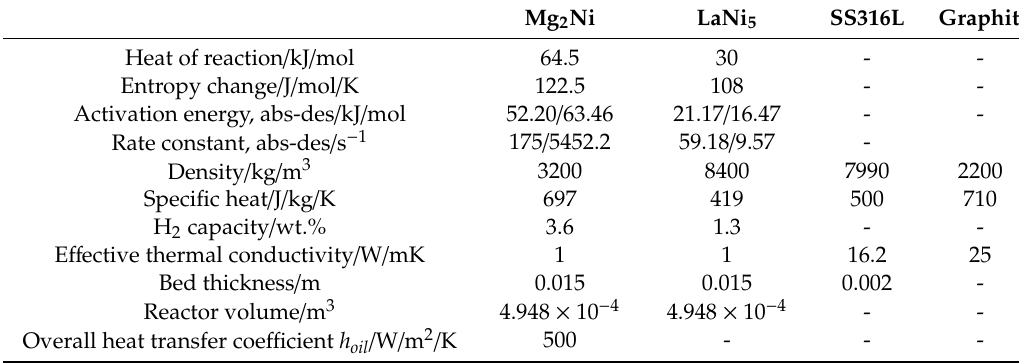
Table 1. The main thermophysical parameters of the materials used in the